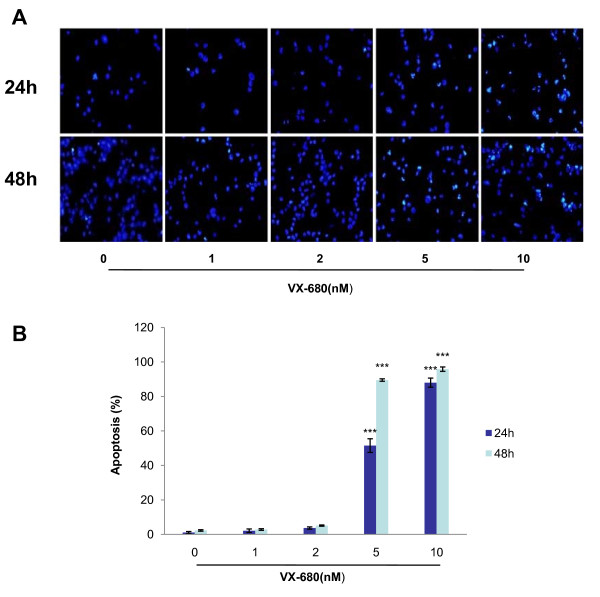
Morphological changes in nucleus after induction of apoptosis by VX-680. (A) VX-680 treated or untreated cells were stained with Hoechst 33342, and observed by fluorescence microscopy (magnification, 400×). (B) Data summarized three independent experiments, ***p < 0.001, compared to control.